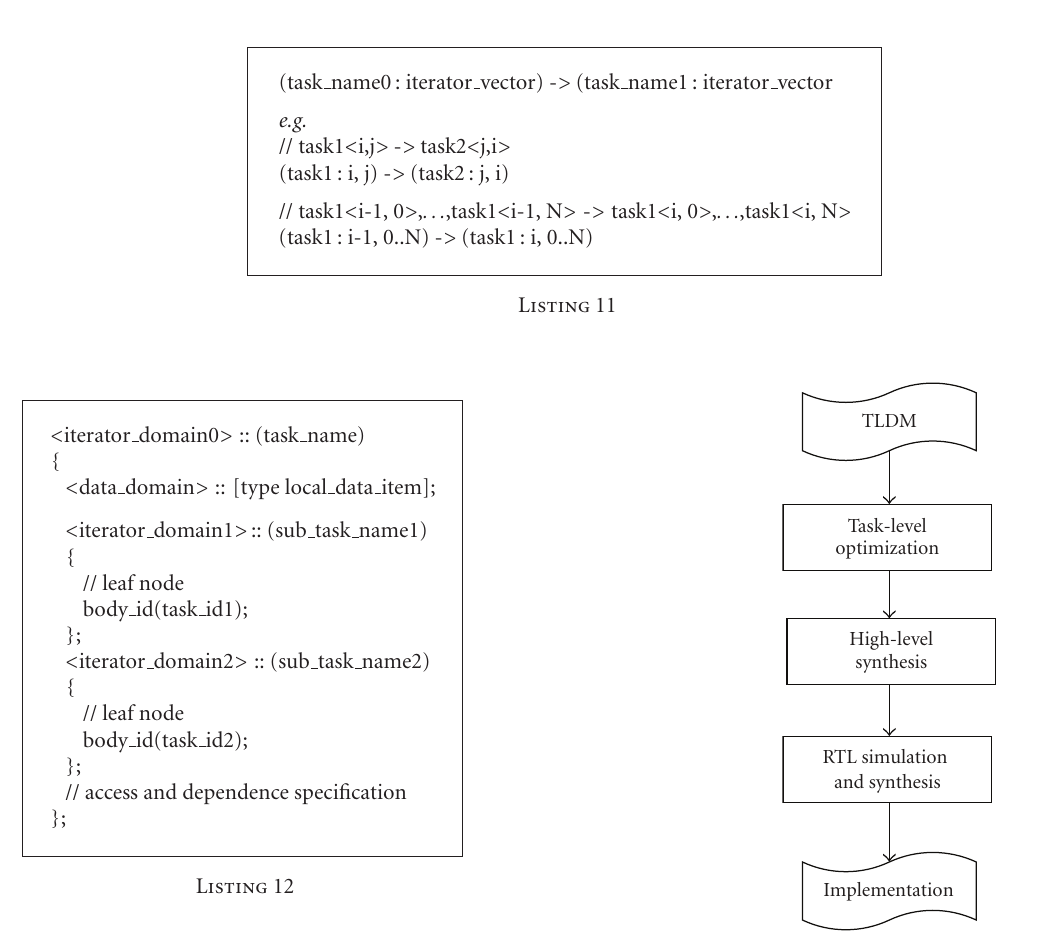
Figure 5: TLDM-based design